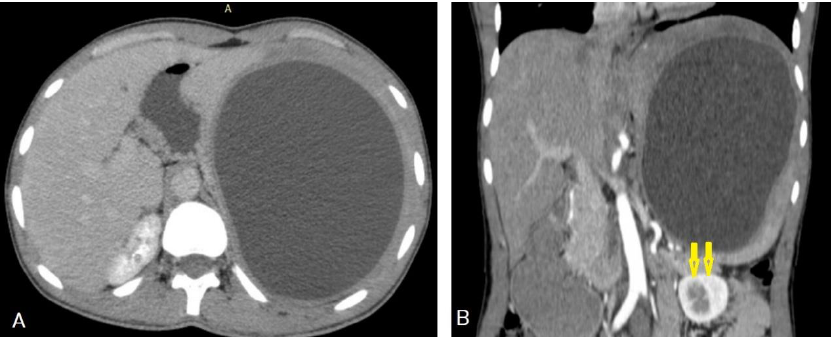
Figure 22. Selected axial ( A ) and coronal ( B ) CT images of a 25-year-old male with left upper abdominal pain and distention, showing about a 15 × 13 cm well-circumscribed, unilocular cystic lesion in the spleen that causes a mass effect in the form of compression and downward displacement of the left kidney (arrows). The lesion showed homogeneous contents, no septations, no calcification, and no enhancement after contrast administration, which is a typical picture of a hydatid cyst of the spleen.